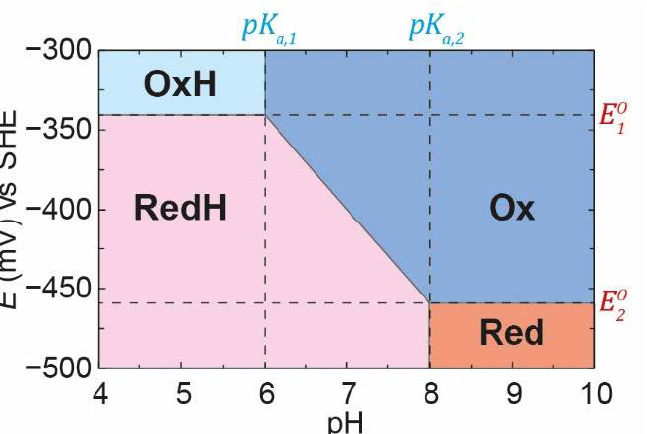
Figure 8. The Pourbaix diagram indicating the regions of relative stability of the species Ox , OxH , Red , and RedH with pH and applied potential ( E ). The values of the constants defining the regions of the diagram are the same as those used in Figure 4: E O = − 459 mV, K a, 1 = 10 − 6 ( pK a, 1 = 6), K a, 2 = 10 − 8 1 ( pK a, 2 = 8). E O was calculated to be − 341 mV, giving an average E O of − 400 mV. The areas of the 2 diagram are coloured to indicate the regions where Ox (dark blue), OxH (light blue), Red (dark red), and RedH (light red)